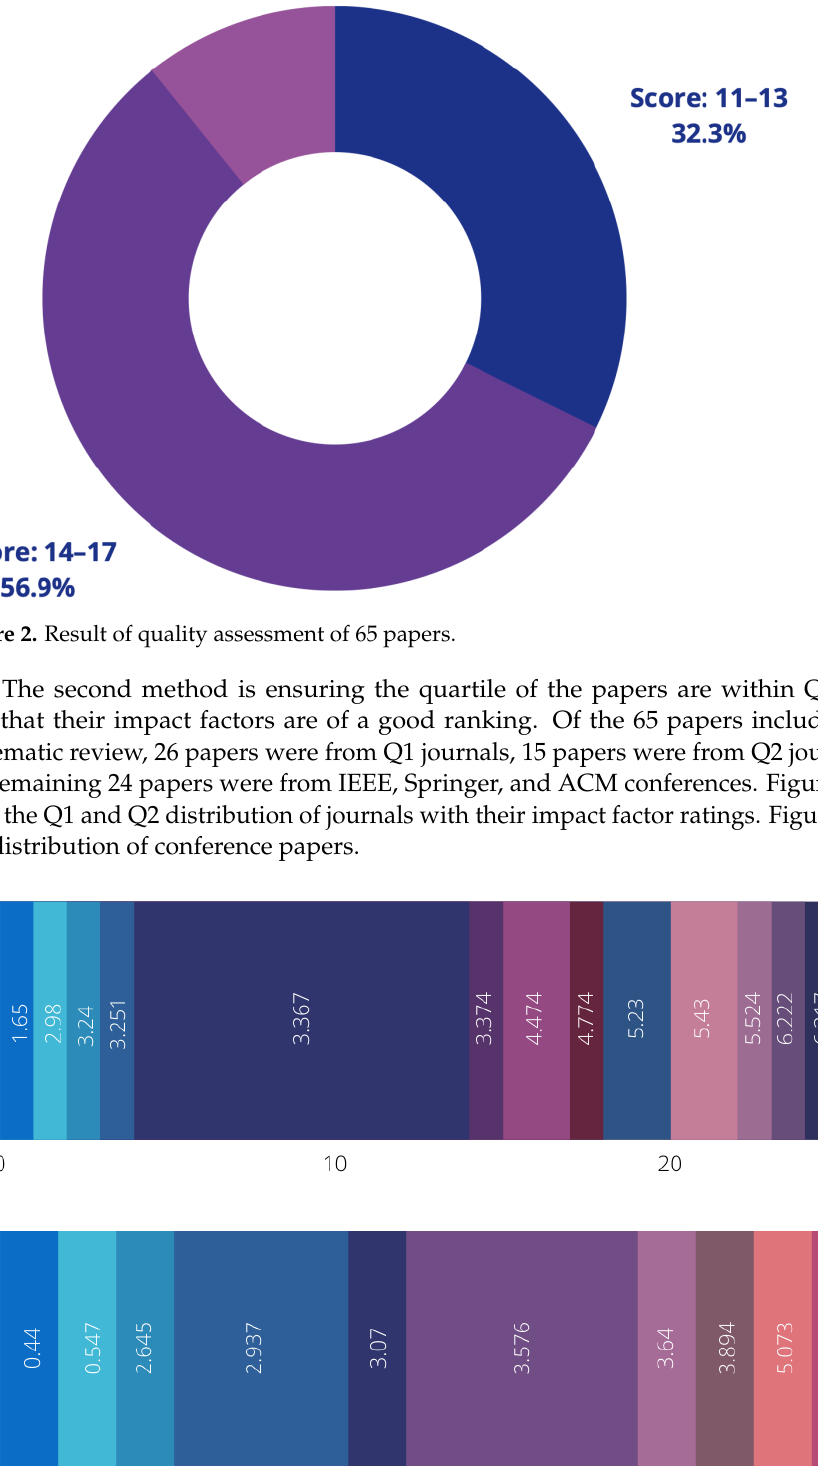
Figure 4. Distribution of conference papers. 2.3. Summary of Proposed Solutions Table 5 lists 65 blockchain-based solutions that were proposed in an attempt to solve issues that exist in EHR. Data extracted from all of the papers were carefully analyzed, from the type of blockchain that was used, the technologies that were utilized for their design, the status of each proposed solution, whether it was a proposal in theory, simu- lated, or implemented, and the challenges that each paper tried to address. There were multiple challenges addressed across each of the 65 novel solutions and these demonstrate